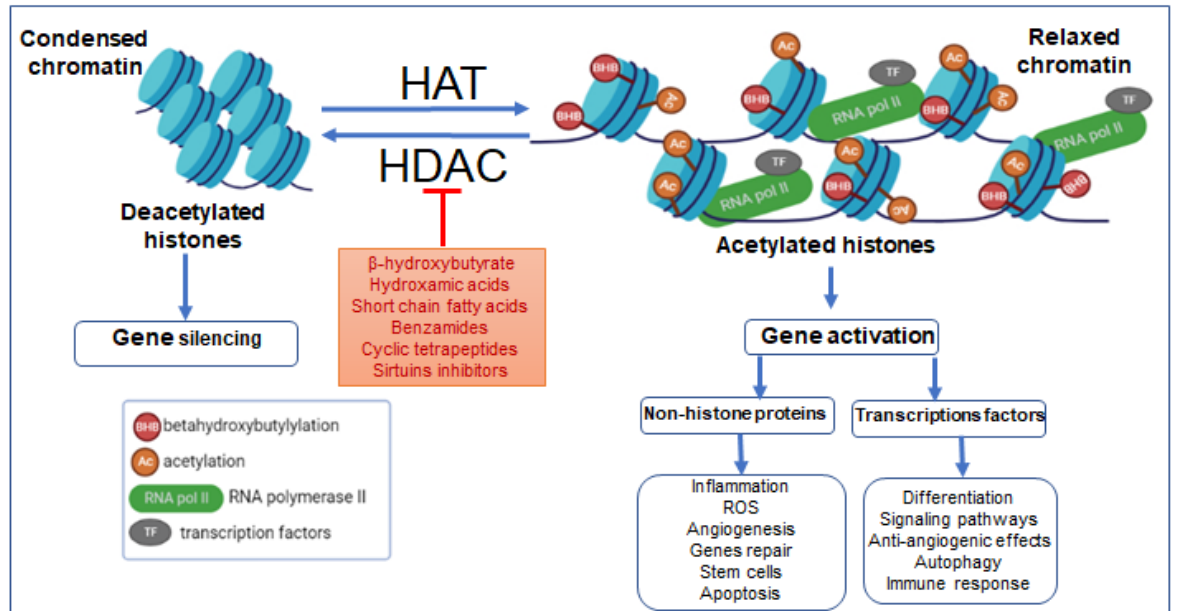
Figure 2. Effects of HAT and HDAC on β -hydroxybutyrylation, the chromatin’s transcriptional dynamics, and consequences of epigenetic remodeling on pathologies. Abbreviations: AC, acetylation; BHB, β -hydroxybutyrylation; TFs, transcription factors; RNA pol II, RNA polymerase II; ROS, reactive oxygen